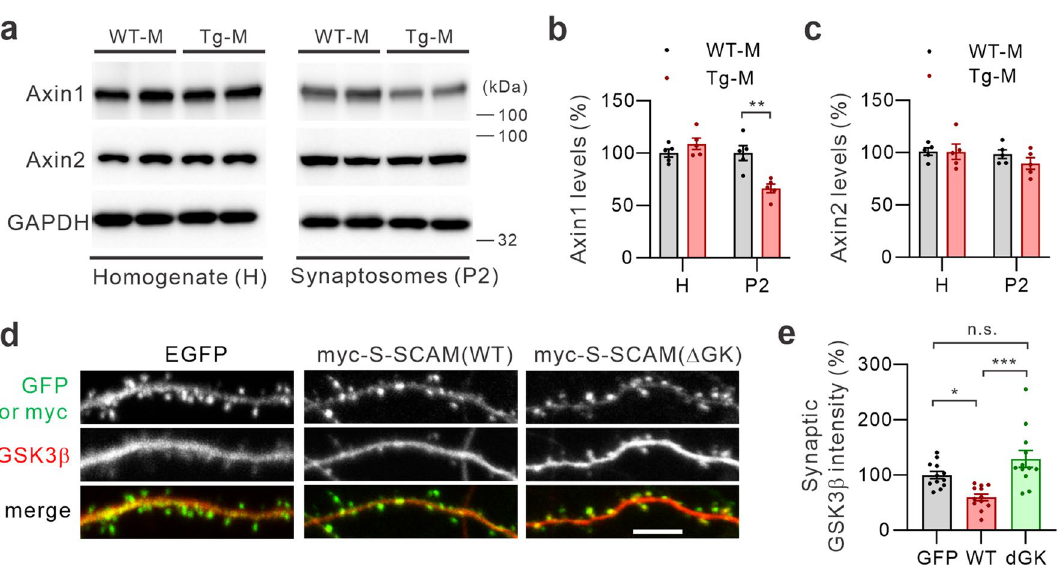
Figure 3. Altered synaptic Axin1 levels are responsible for the reduction of synaptic GSK3β. ( a – c ) Reduced Axin1 levels in the P2 fraction of male S-SCAM Tg mice. Representative immunoblots ( a ), quantification of Axin1 ( b ) and Axin2 protein levels ( c ). n = 5 mice per group. ** p < 0.01, unpaired t -test with Welch’s correction. ( d , e ) Removal of the GK domain in S-SCAM prevents the loss of synaptic GSK3β in cultured hippocampal neurons. Representative images ( d ) and quantification of synaptic GSK3β immunofluorescent intensity ( e ). n = 12 neurons per group. One-way ANOVA, F (2,33) = 11.62, p < 0.001. Tukey’s multiple comparison test: *** p < 0.001, * p < 0.05. Scale bars represent 5